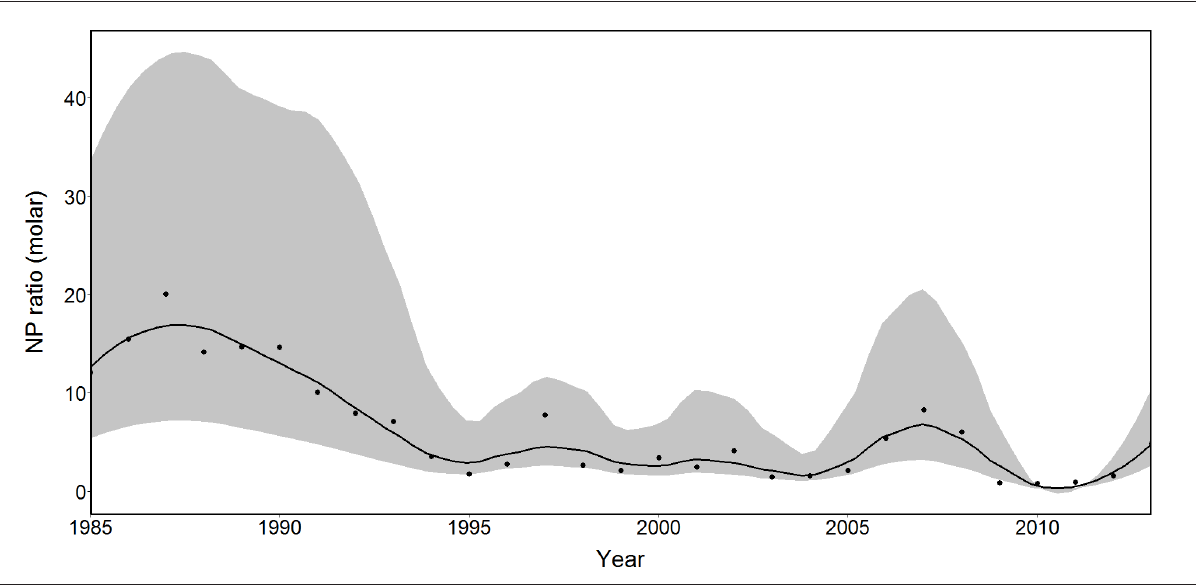
Annual median molar nitrogen-to-phosphorus (NP) ratio in South African fresh water plotted against time. The points show the median molar nitrogen-to-phosphorus ratio per year; the line is a loess smoother; and the grey ribbon spans the 25th to 75th